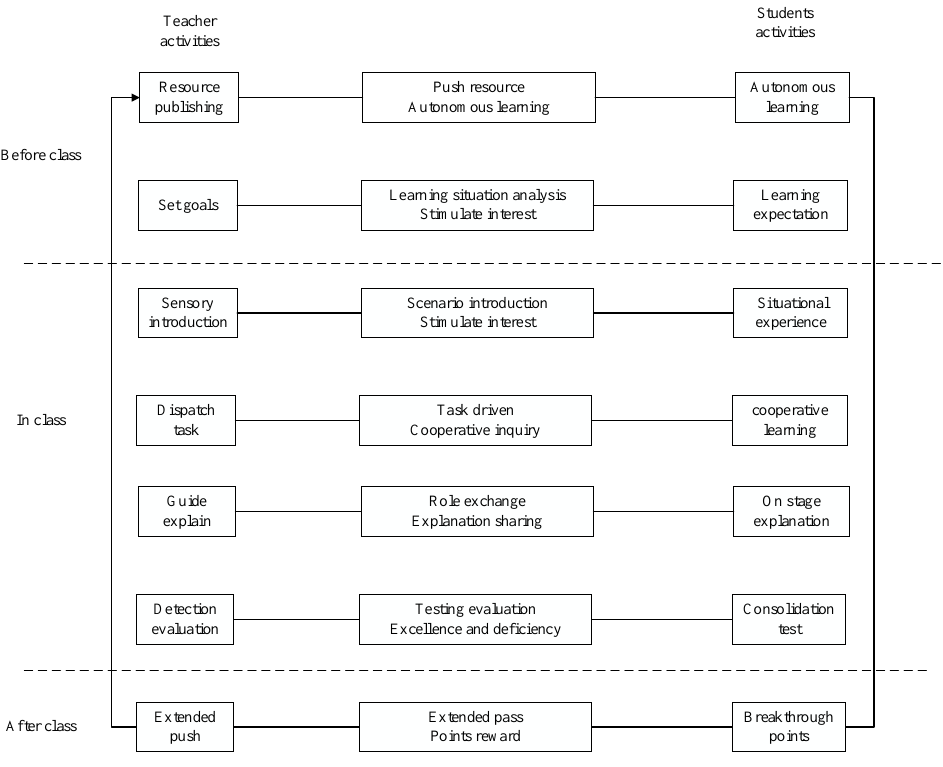
Figure 3. “7 + 7” mode of intelligent music teaching.